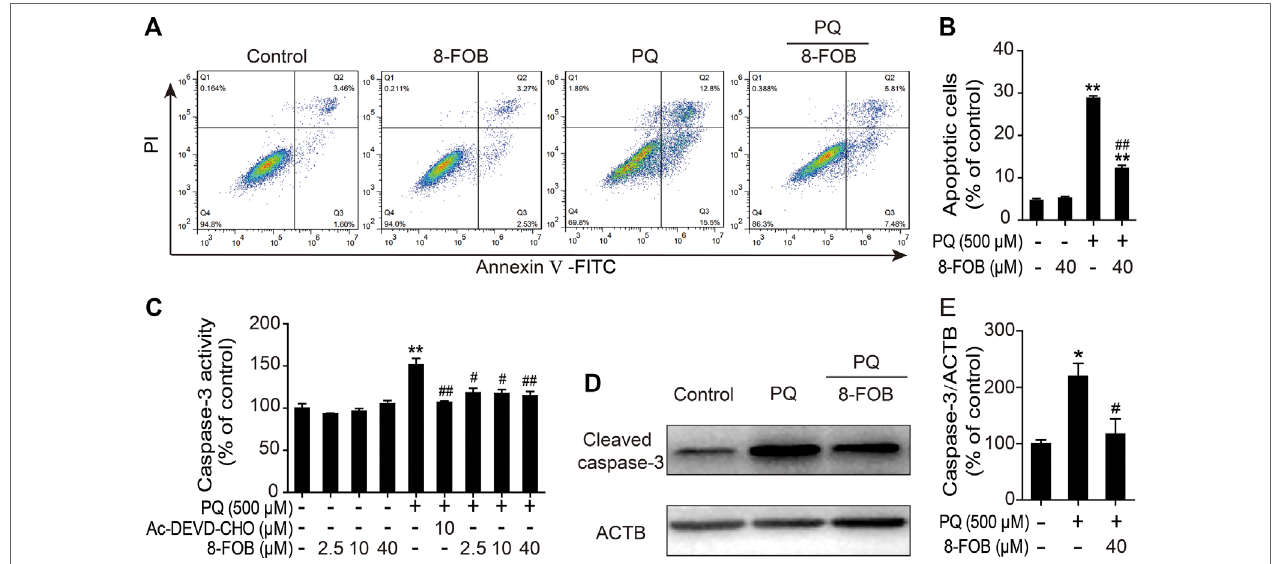
FIgURe 5 | 8-Formylophiopogonanone B (8-FOB) mitigates paraquat (PQ)-induced apoptosis in L02 cells. (A) Representative images showing the effects of 8-FOB inhibition on PQ-induced apoptosis determined by flow cytometry. The annexin V–fluorescein isothiocyanate (FITC)−/propidium iodide (PI)− population consists of normal healthy cells (Q4); annexin V–FITC+/PI− cells indicate early apoptosis (Q3); annexin V–FITC+/PI+ cells indicate late apoptosis or necrosis (Q2); annexin V– FITC−/PI+ cells are necrotic cells (Q1). (B) Quantification of apoptosis ratios. (C) Detection of caspase-3 activity after 24 h of PQ (500 μM) treatment. Ac-DEVD-CHO: a specific caspase-3 inhibitor. (D) Detection of caspase-3 expression levels after 24 h of PQ (500 μM) treatment. (e) Quantification of cleaved caspase-3 levels relative to those of β -actin. The values are presented as the means ± SEM ( n = 6). * p < 0.05, ** p < 0.01 vs the control group; # p < 0.05, ## p < 0.01 vs the PQ